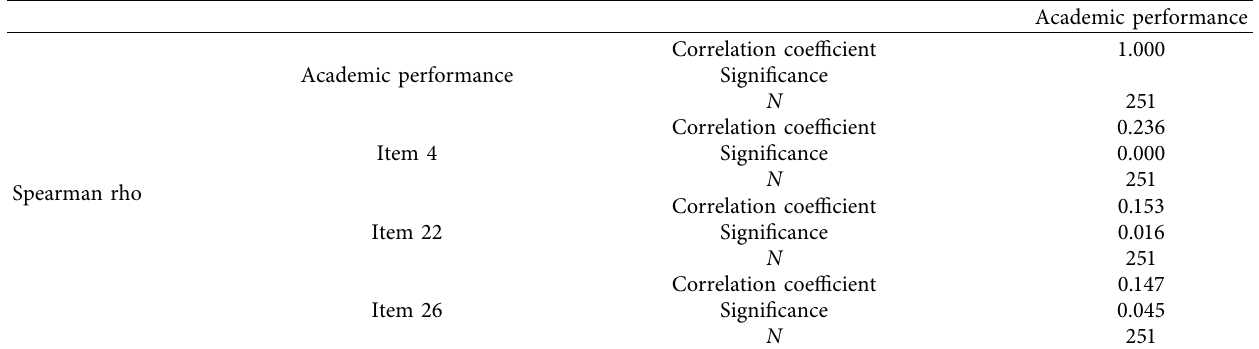
Table 8: Relationship between the instrument items and academic